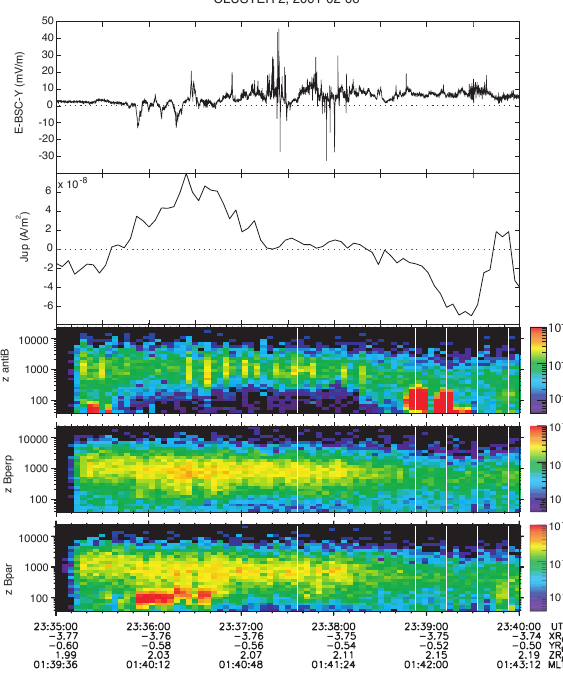
Fig. 10. EISCAT measurement from the downward FAC region poleward of the arc. Top panel shows electron densities and bottom panel ion temperature.